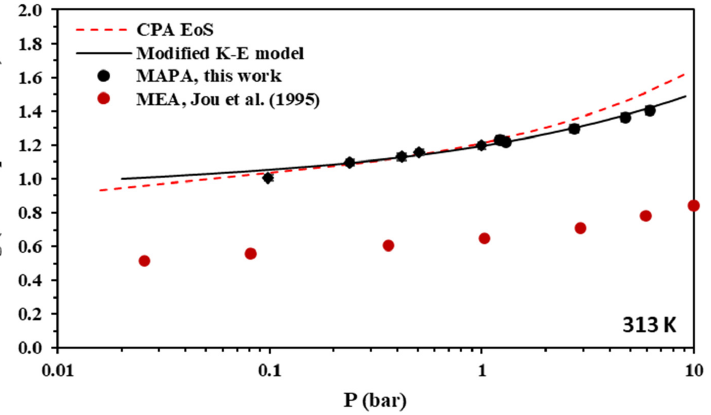
Figure 8. Solubility of CO 2 in aqueous MAPA (30.0% wt.) solutions at 313 K. Experimental data (points, from this work) and correlations (lines) with the CPA equation of state and the modified Kent–Eisenberg model. Experimental data for MEA [55] are also shown for comparison.